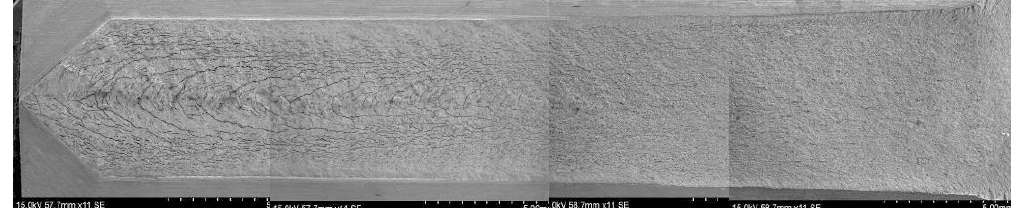
Figure 3. Typical macroscopic observation of sulfide stress cracking (SSC) fracture in double cantilever beam (DCB) sample tempered at 700 ° C .